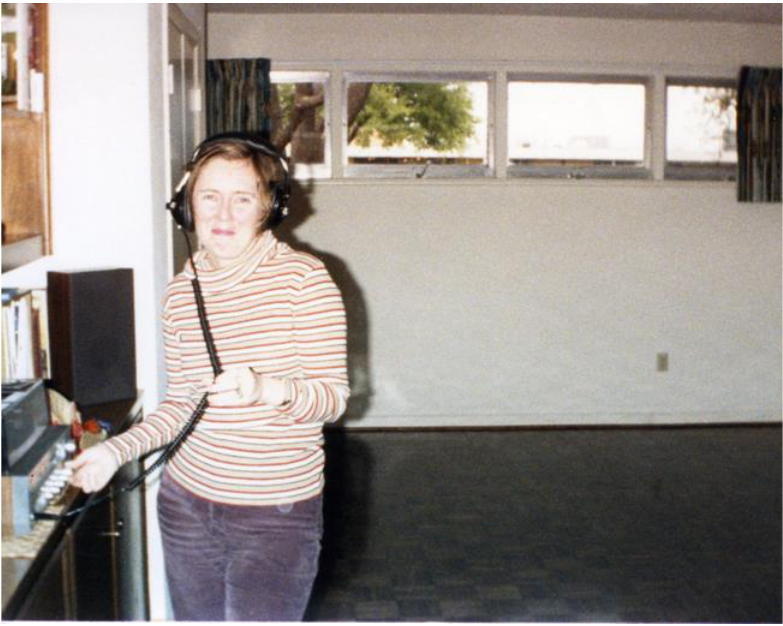
Figure 8: Dona Thornton in her 20’s, playing music. “She was my aunt and also my playmate.” Courtesy: Sophie